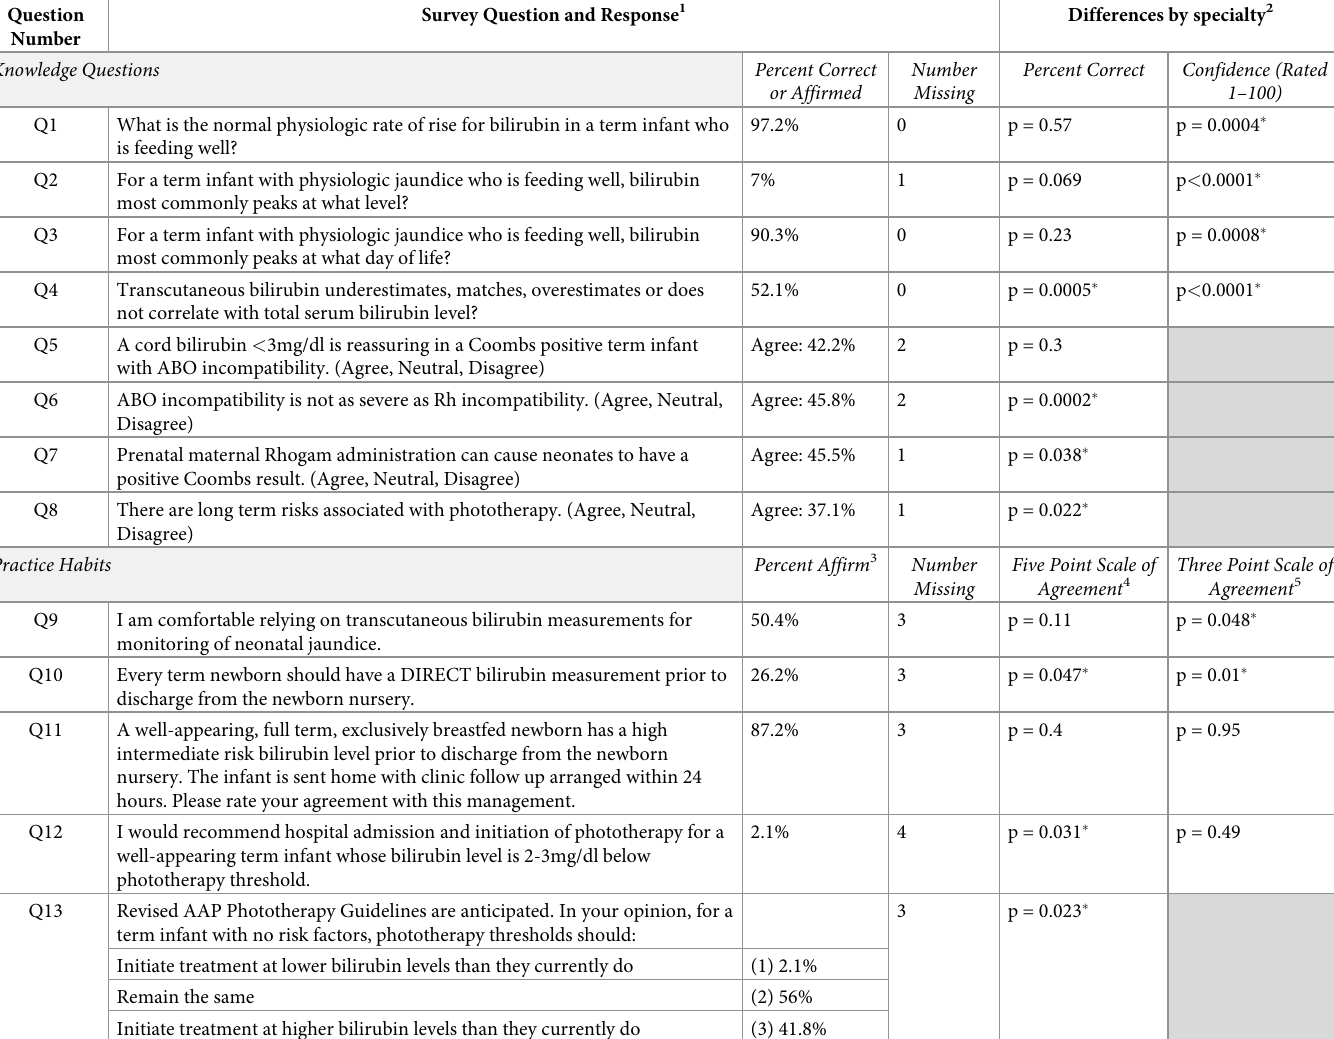
Table 1. Survey questions, responses, and differences by